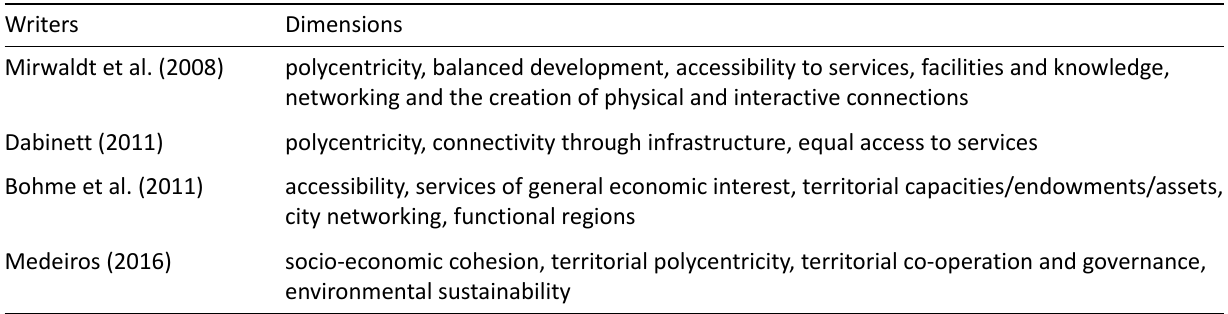
Table 1. Dimensions of territorial